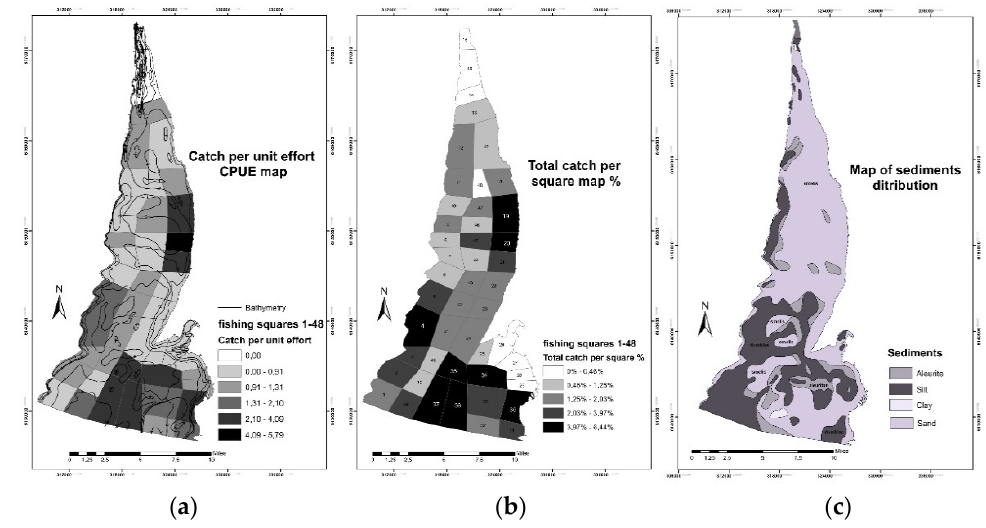
Figure 1. Overlay maps of Curonian lagoon. ( a ) Distribution of CPUE in each fishing square (1–48), ( b ) distribution of catch in percentage for each FS from a total landing, and ( c ) main bottom sediments distribution in Curonian lagoon.